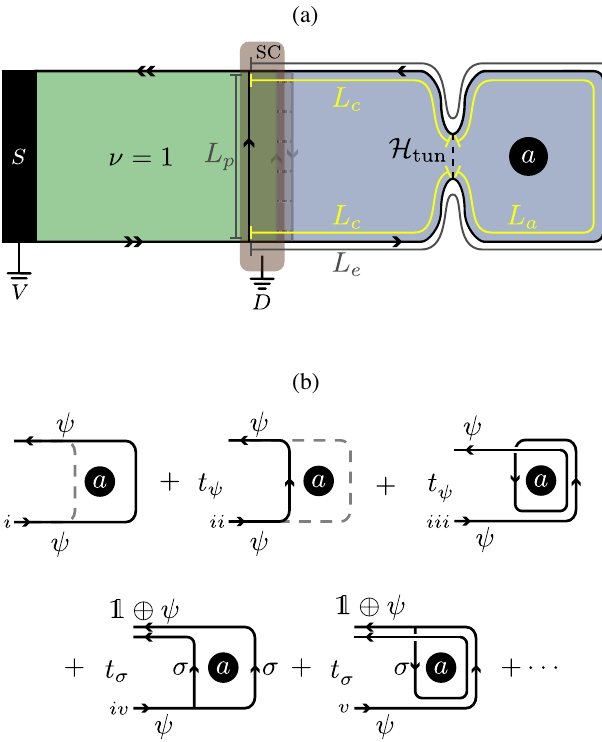
FIG. 10. (a) Interferometer that electrically detects both bulk Ising anyons and bulk emergent fermions. The geometry can be viewed as Fig. 9 with a constriction in the spin liquid, governed by H in Eq. (34). At the constriction, incident emergent tun Majorana fermions can either tunnel across ( t ψ process) or fractionalize into a pair of Ising anyons ( t σ process) — one hopping across and the other encircling a bulk quasiparticle of type a ¼ I , ψ , or σ . Nontrivial braiding statistics among the anyons in the spin liquid yields a -dependent electrical conduc- tances [Eqs. (57) and (59)] that enable readout of the quasiparticle type. Most notably, non-Abelian statistics between Ising anyons vanquishes first-order conductance corrections from t σ events. (b) Illustration of the five paths taken by incident emergent fermions up to first order in H . For details, see Secs. VII A tun and VII B. The ellipsis denotes higher-order contributions not included